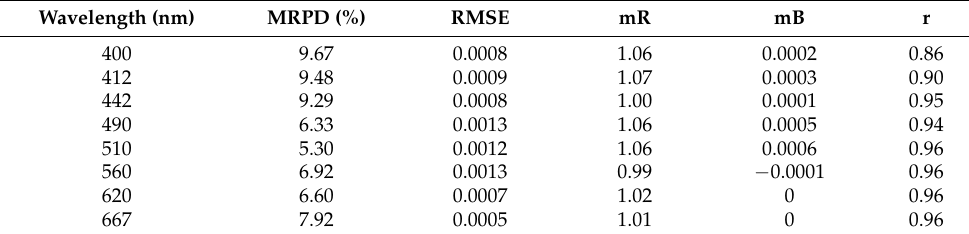
Table 4. Statistical parameters for the comparison of R rs determined by SeaPRISM and RAM- SES_AUTO at the Muping site including median relative percentage difference (MRPD), root mean square error (RMSE, in sr − 1 ), mean ratio (mR), mean bias (mB, in sr − 1 ), and Pearson correlation efficient (r).